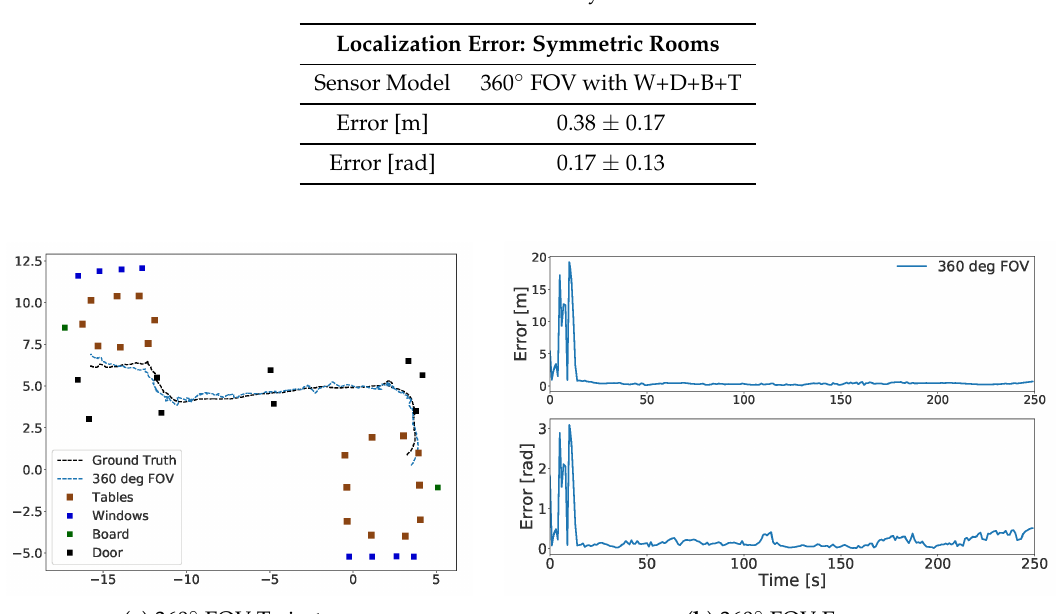
Table 4. Localization error: symmetric rooms.